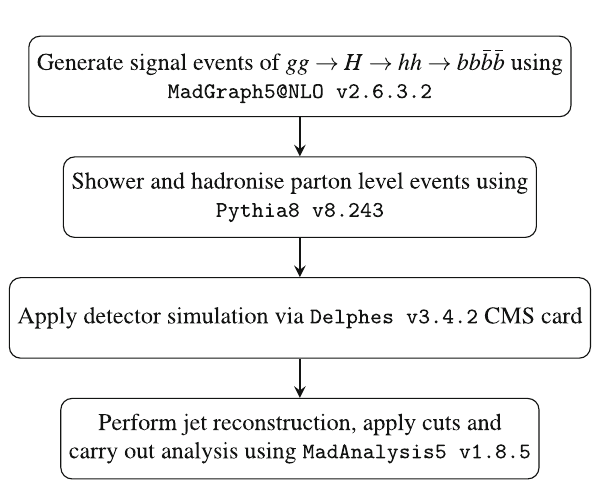
Fig. 4 Description of the procedure used to generate and analyse MC